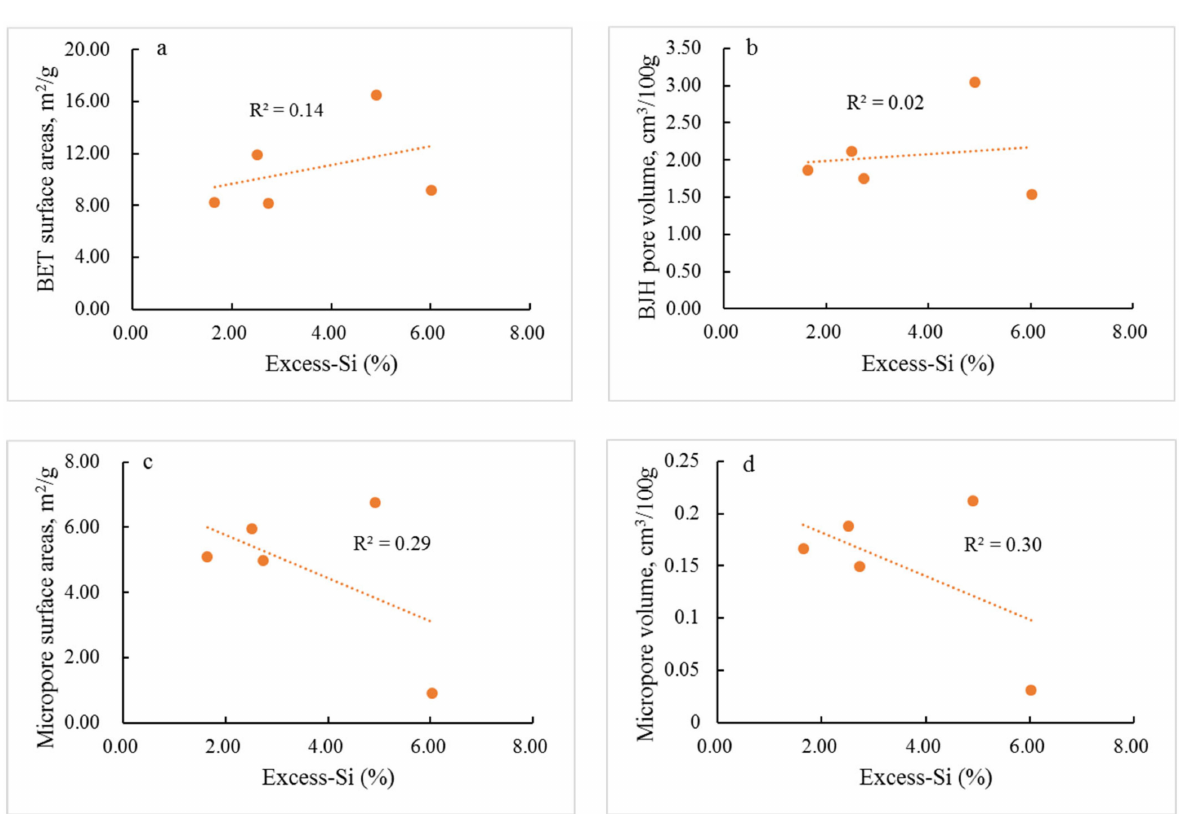
Figure 15. Mesopore surface areas and volume versus Excess-Si content ( a , b ); micropore surface areas and volume versus Excess-Si content ( c , d ) for argillaceous